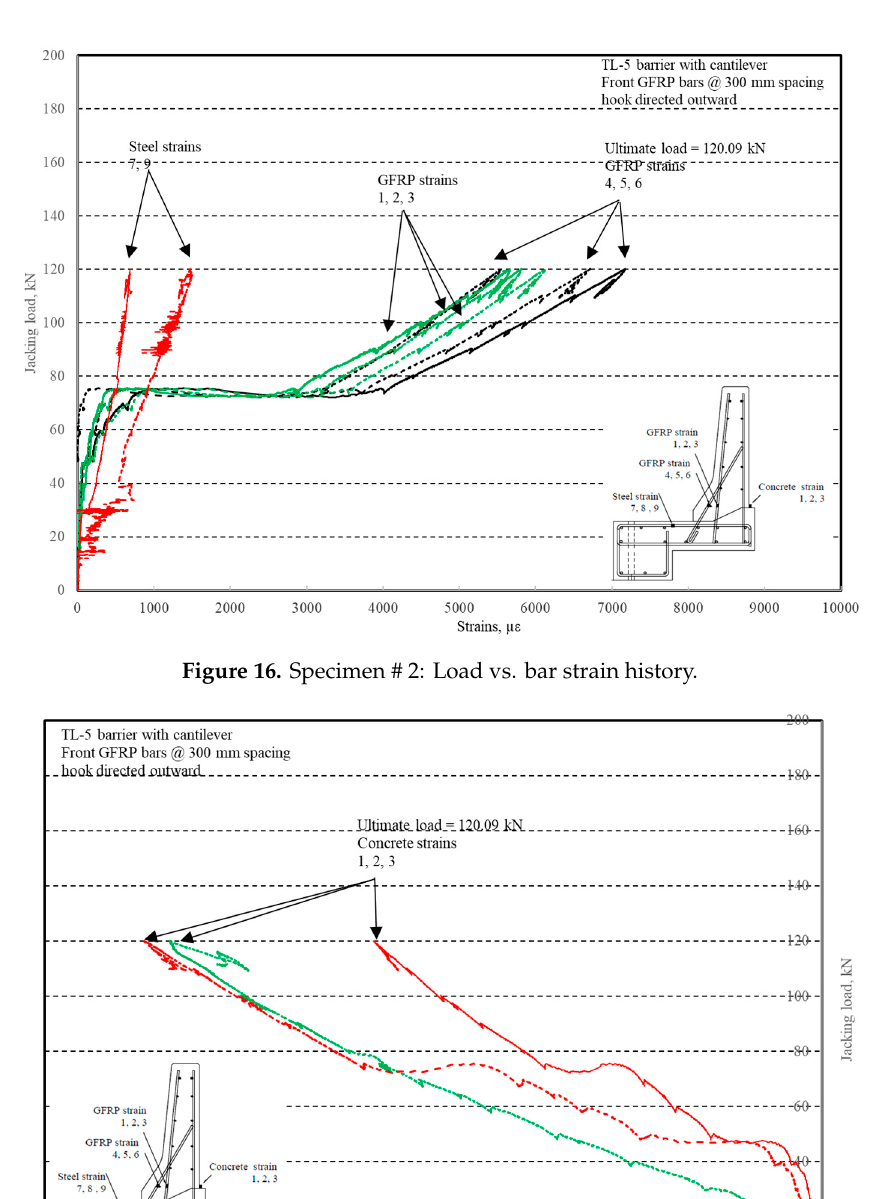
Figure 15. Specimen # 2: Load vs. displacement history.